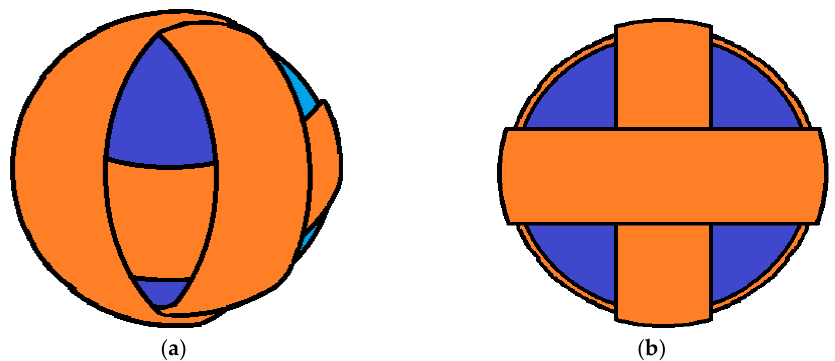
Figure 22. Three-dimensional design of future work configuration for a three-dimensional harvester: ( a ) Side view; ( b ) Front view.